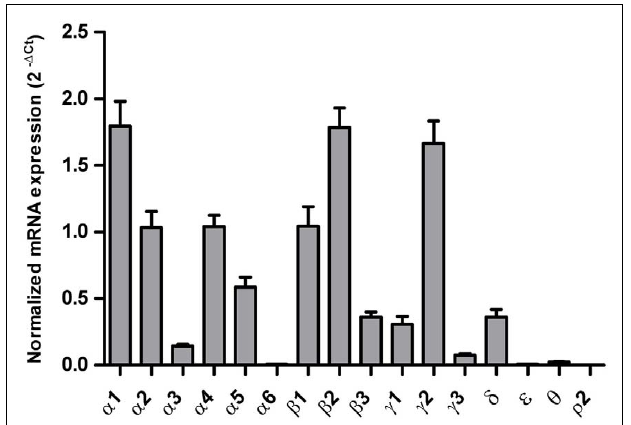
FIGURE 3 | Expression of GABA A channel subunit mRNAs in the orbitolfrontal cortex of controls ( n = 14). The mRNA level of each subunit was normalized to reference genes PPIA and PGK1 and presented as mean ±